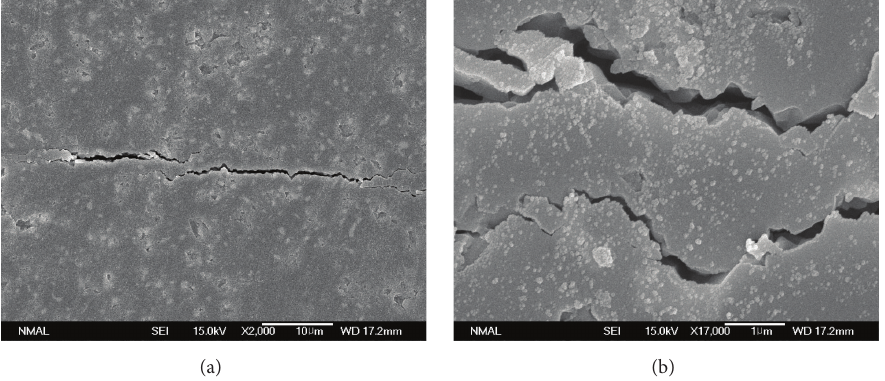
Figure 7: SEM image (a) and enlarged SEM image (b) of crack propagation from hot-pressed Al 2 O 3 -15wt.% Ni-P composite.